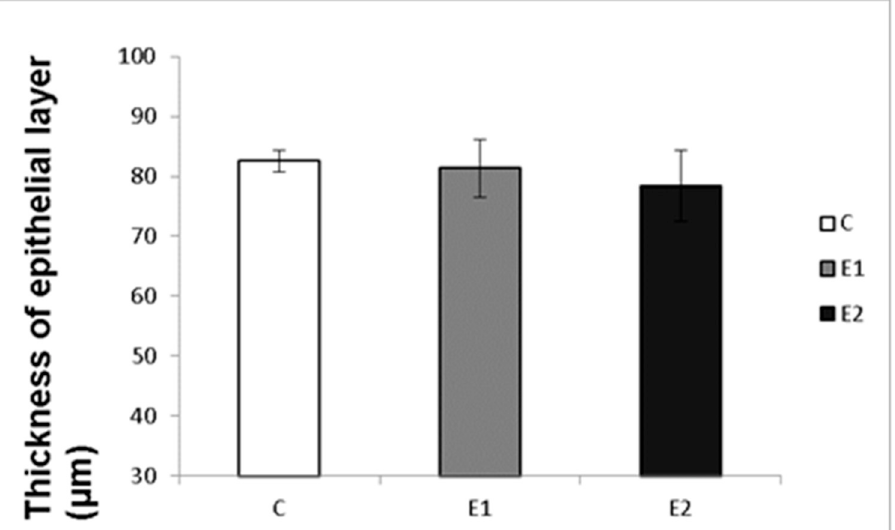
Figure 8. Effect of green tea on the thickness of tubular epithelial layer. C (without dietary green tea). E1–5 g green tea/100 kg normal food. E2–20 g green tea/100 kg normal food. Values and error bars express means ± SEM.